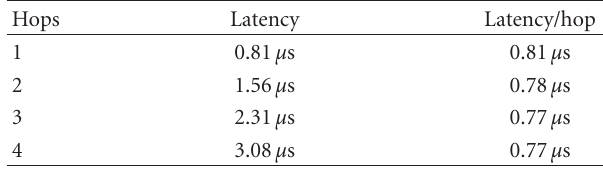
Table 4: Node-to-node latency with AIREN router.